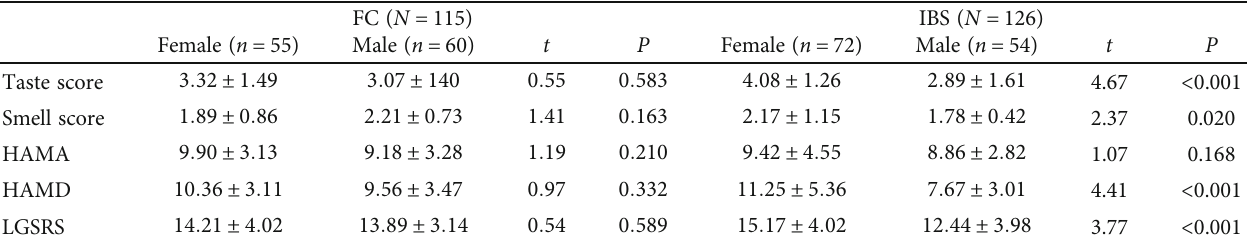
Table 6: Gender-related di ff erences of taste, smell, HAMA, HAMD, and LGSRS scores in FC and IBS